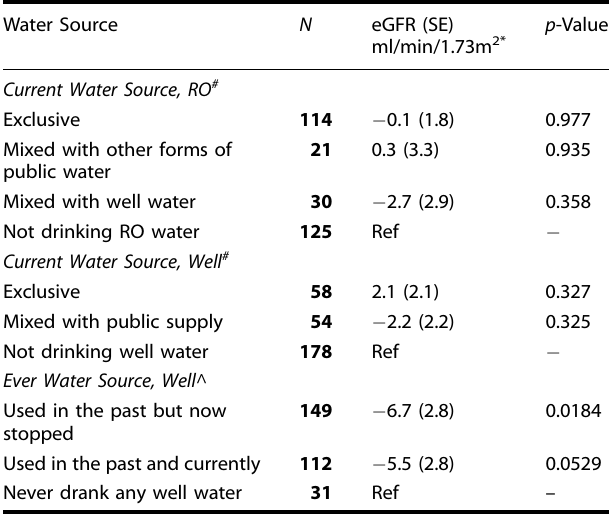
Table 3. The relationship of water source to CKDu from linear mixed models on age- and sex-adjusted eGFR during the study period (18